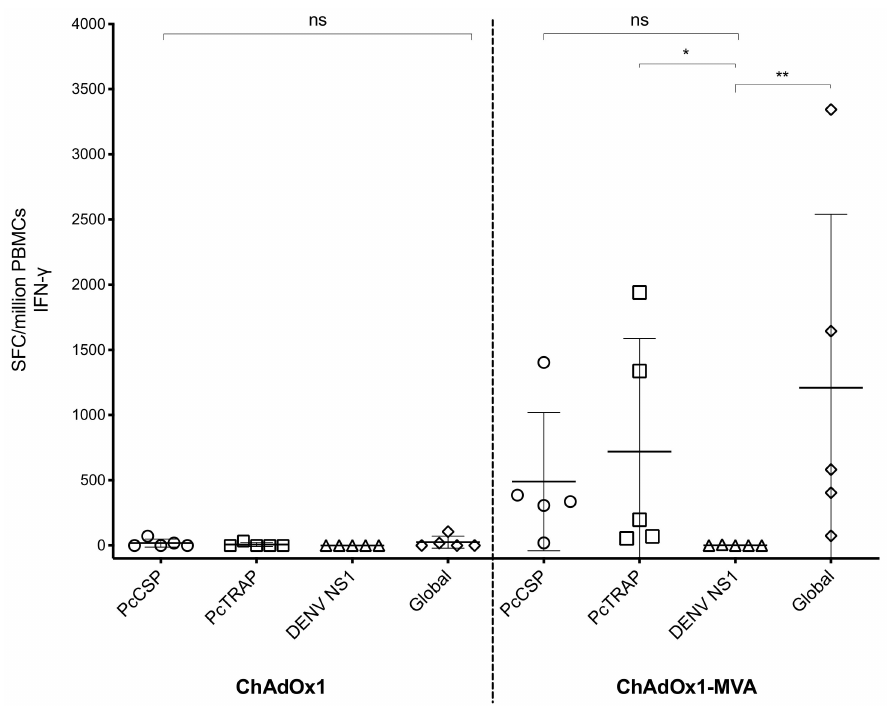
Figure 6. T cell immune responses elicited by ChAdOx1 / MVA vaccines in rhesus macaques by ELISpot. PBMCs were cultured with peptide pools spanning the PcCSP and PcTRAP proteins and responses following prime and prime-boost immunizations were assessed using an ex vivo IFN-gamma ELISpot. Values represent the spot-forming cells (SFC) per million PBMCs resulting from stimulation with 20-mer overlapping by 10 peptides spanning the whole PcCSP and PcTRAP structural proteins (10 µ g / mL). Individual data are shown as symbols and mean + SD are represented as the horizontal bars. PBMC samples were collected at 2 weeks after prime immunization and 2 weeks after P-B immunization. p -values were determined by Kruskal–Wallis test and Dunn’s multiple comparisons test. p > 0.05 (ns), p < 0.05 (*), p < 0.01